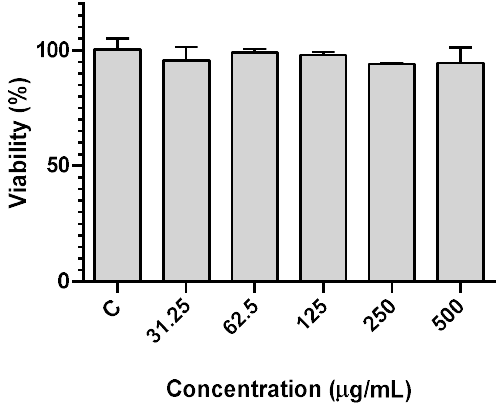
Figure 3. Viability of AGS cells exposed to opuntia extract for 24 h, as assessed by the MTT assay.